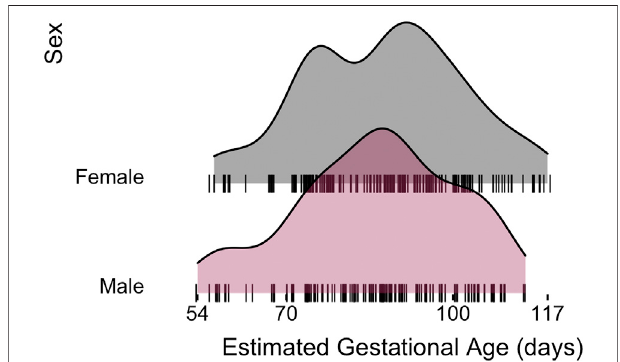
FIGURE2|(A) Top10miRNAsby p -valuearedepictedwiththeireffectsizeexpressedaslog 2 (foldchange)with95%con fi denceintervals.Estimatedfoldchanges (miRNAcountsinmalescomparedtofemalesamples)andq-valuesarealsopresented. (B,C) showexamplescatterplotsofresidualizedmiRNAlevels( y -axis)plottedby sex ( x -axis). Residuals are displayed toillustrate sex-differences after adjusting forcovariates including, age, age (Tordayet al., 1981),smoke exposure, technical batch, and the four RUV-inferred covariates to emphasize effects of sex.